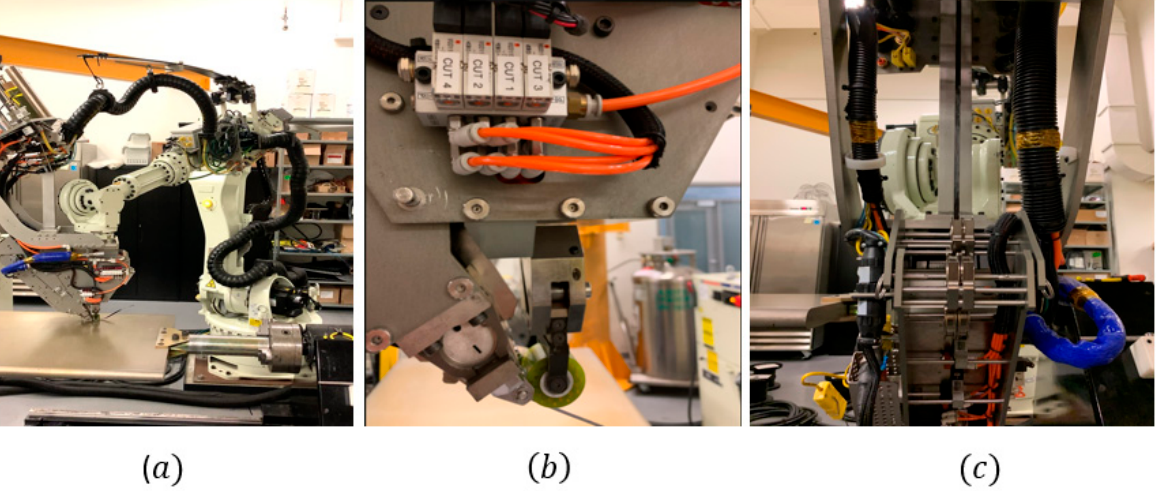
Figure 1. Automated fiber placement machine: ( a ) fiber placement with a six-axis robot arm, ( b ) the head and the roller-tape contact, ( c ) the guidance system.